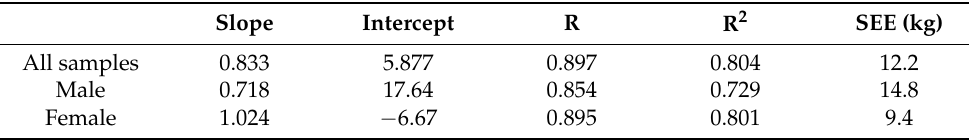
Table 5. Equations of the linear regression of the total sample and by sex in training group. Slope All samples